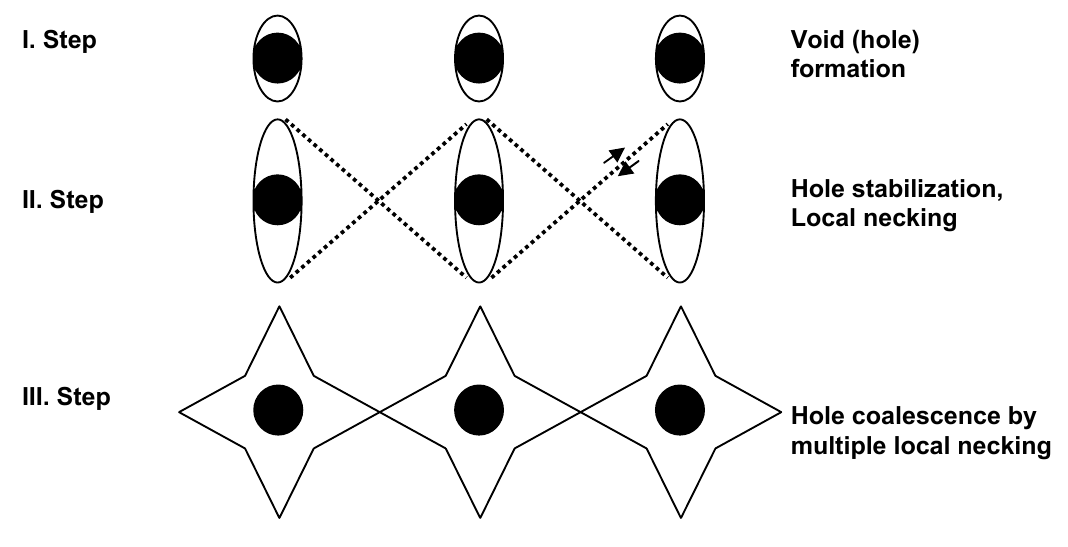
Figure 3. Stages of crack formation around rigid particles in a ductile matrix (adapted from